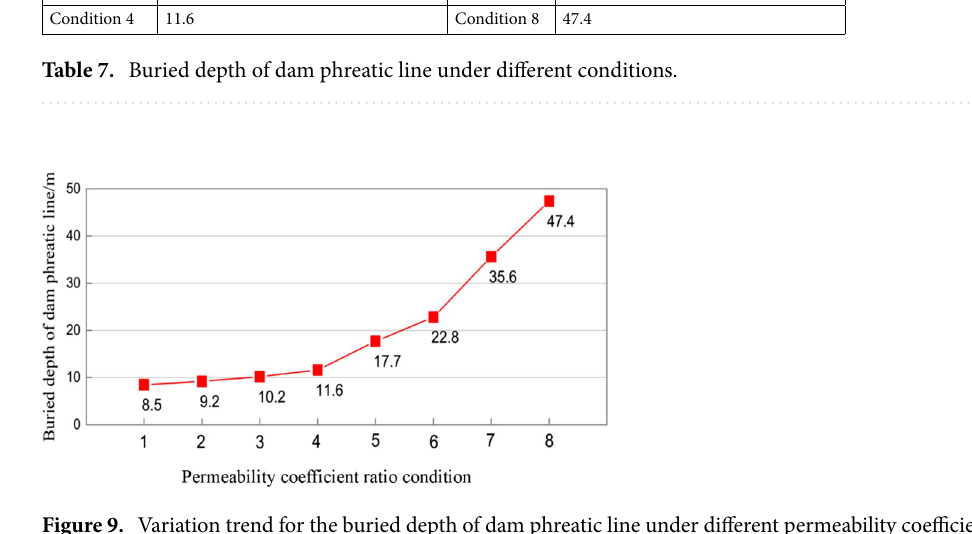
Figure 9. Variation trend for the buried depth of dam phreatic line under different permeability coefficient ratio